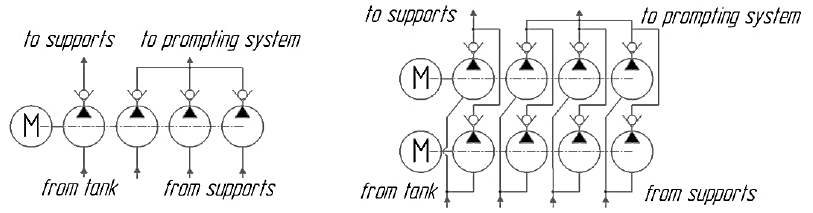
Figure 15. Connection diagram of oil pumps with electric drives.